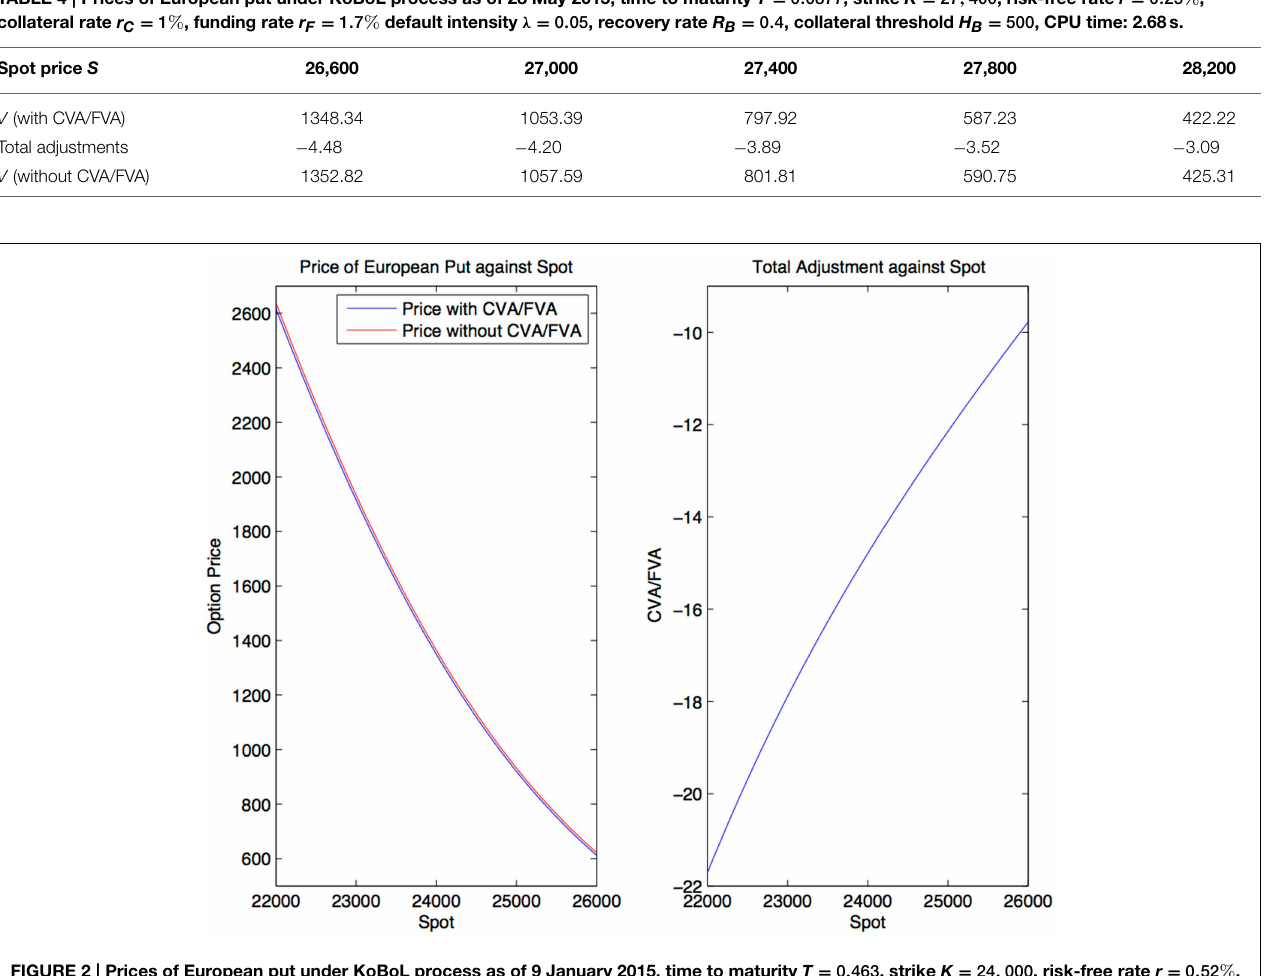
FIGURE 2 | Prices of European put under KoBoL process as of 9 January 2015, time to maturity T = 0 . 463 , strike K = 24 , 000 , risk-free rate r = 0 . 52 % , collateral rate r C = 1 % , funding rate r F = 1 . 7 % default intensity λ = 0 . 05 , recovery rate R B = 0 . 4 , collateral threshold H B = 500